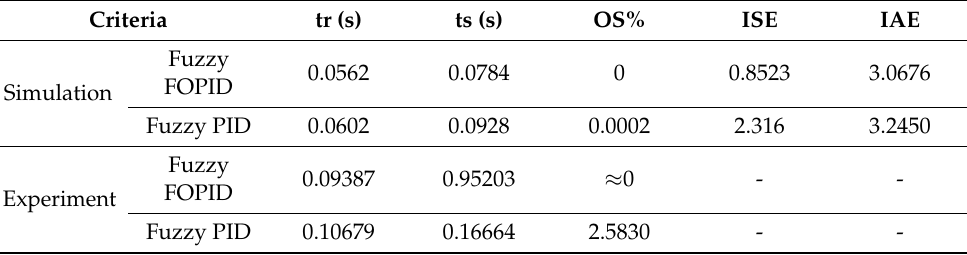
Figure 19. Simulation performances for the IPA with sinewave input.